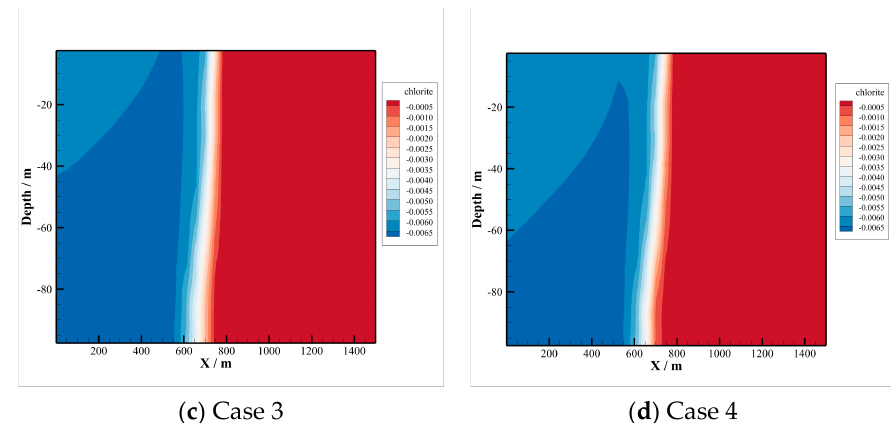
Figure 15. Chlorite dissolution in different cases.